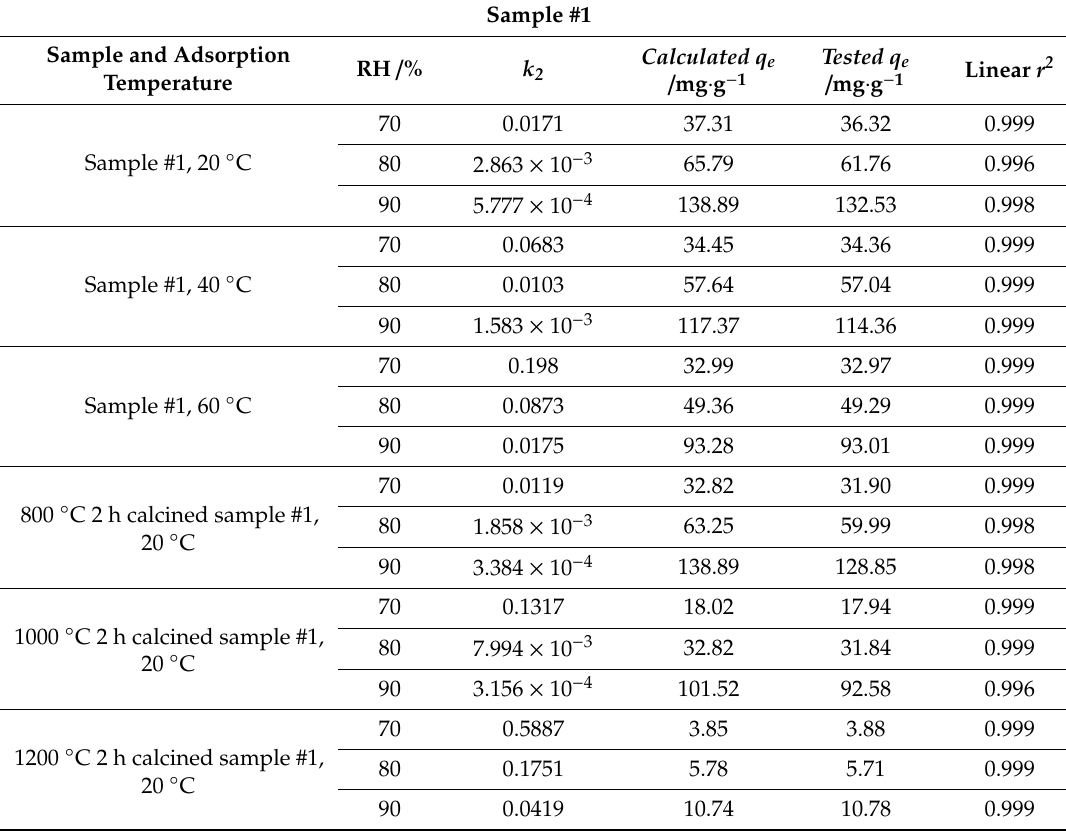
Table 7. Comparison of the calculated ( Calculated q e ) and tested ( Tested q e ) equilibrium adsorption capacities from the pseudo-second-order kinetic